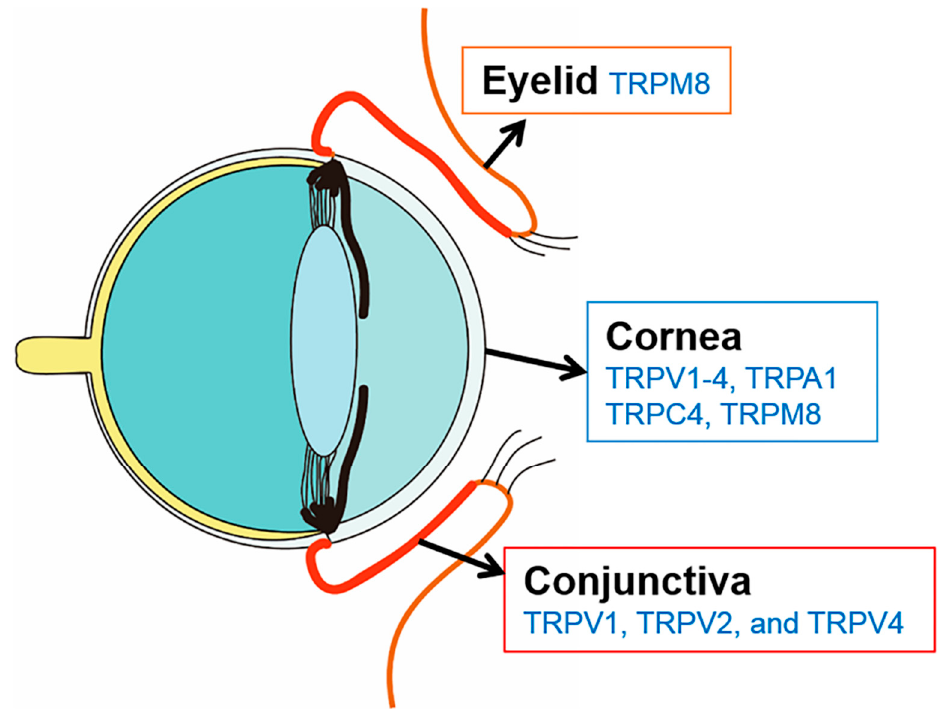
Figure 1. Illustration depicting identified transient receptor potential (TRP) channels in the human anterior surface.